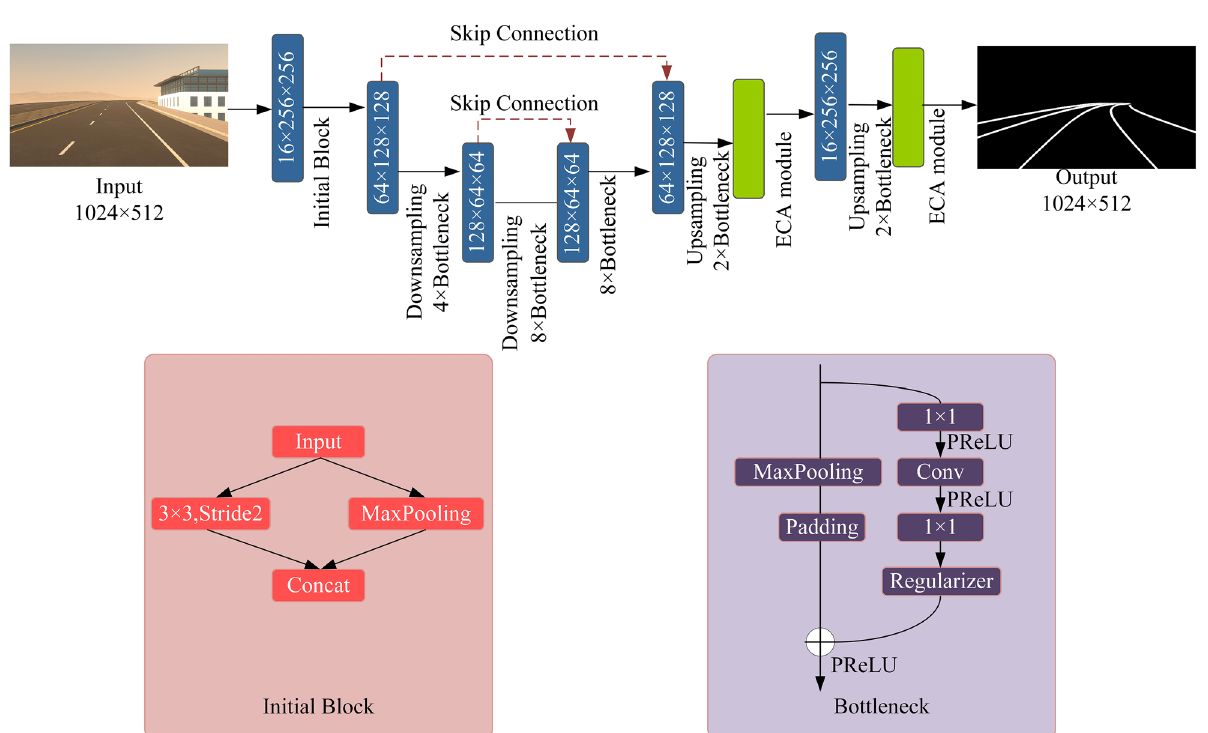
Figure 6. The architecture and composition of the improved ENet